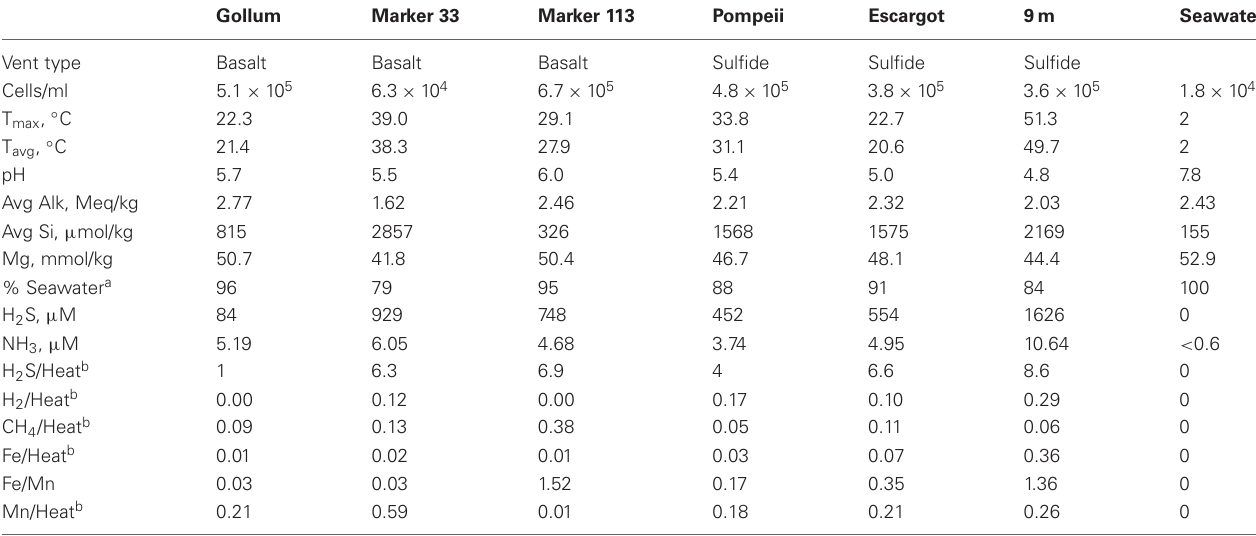
Table 1 | Characteristics of vent fluid and seawater